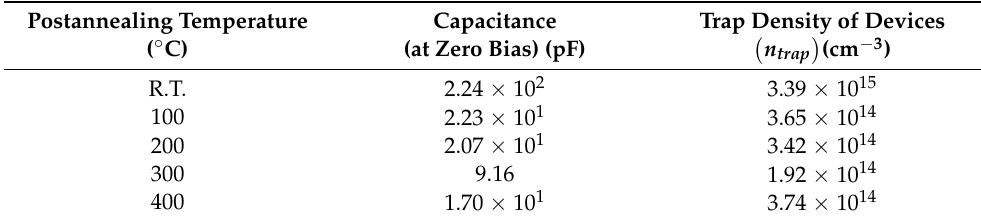
Table 2. Diode parameters of CuO/ β -Ga 2 O 3 heterojunction as a function of postannealing temper- ature using capacitance–voltage measurements, and trap density of photodetector with different postannealing temperatures investigated via space-charge-limited